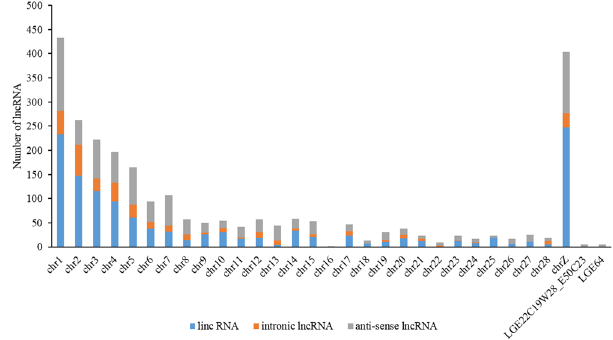
Figure 1. The distribution of testis lncRNA on chicken chromosome.